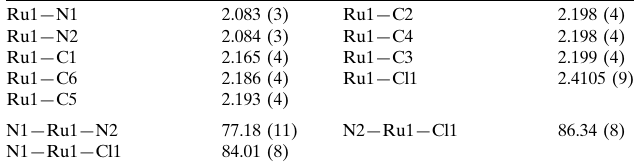
Selected geometric parameters (A˚ , (cid:2) ).